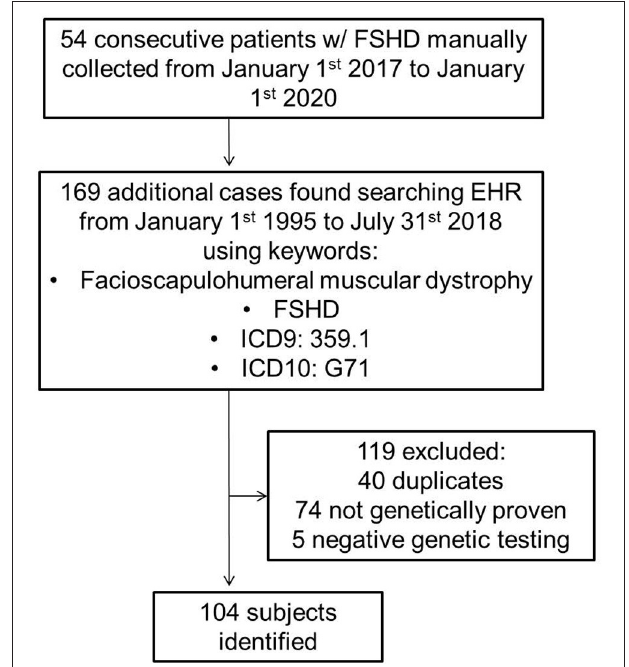
FIGURE 1 | FSHD, facioscapulohumeral muscular dystrophy; EHR, electronic health